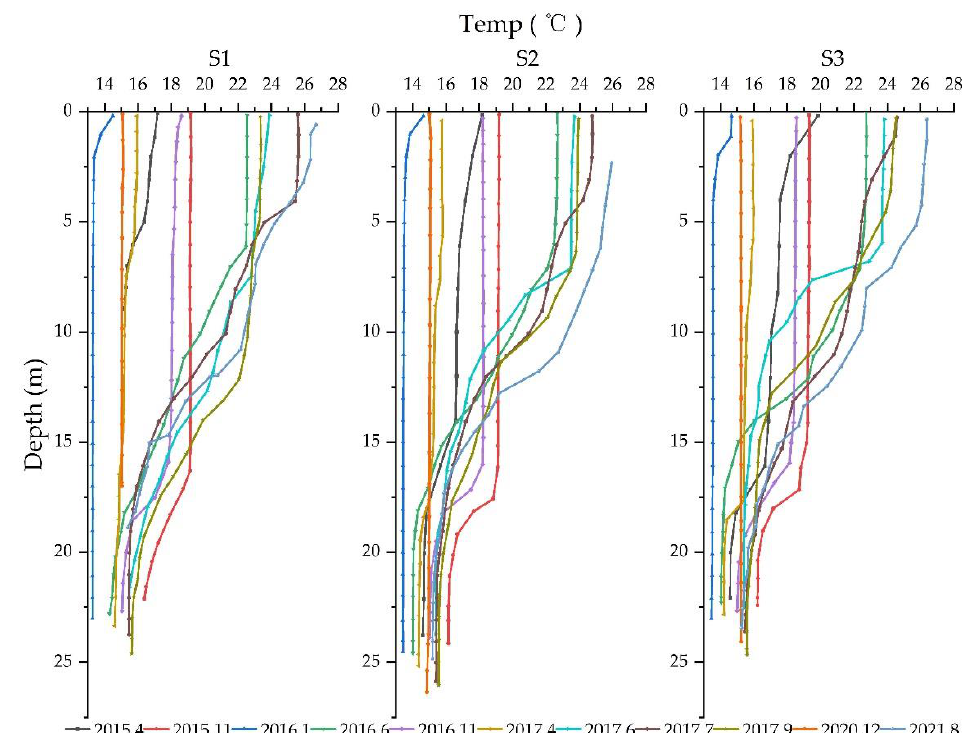
Figure 2. Vertical profile of the water temperature in Lake Yangzong.